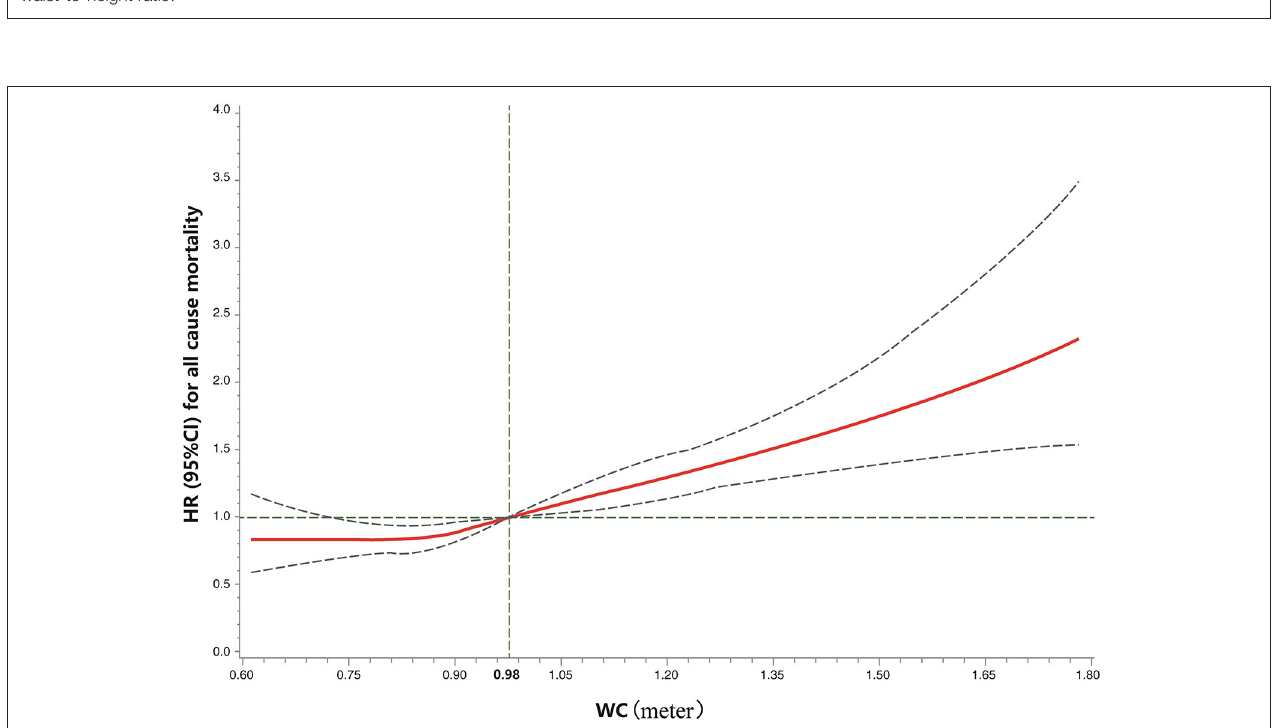
FIGURE 2 | Restricted cubic spline model of the association between the WC and all-cause mortality. Legend: Adjusted for demographics, lifestyle factors, body mass index, and chronic health conditions. The solid curve represents the HRs, and the dashed curves represent the 95% CIs. P overall < 0.01, P nonlinear = 0.52. WC, waist circumference